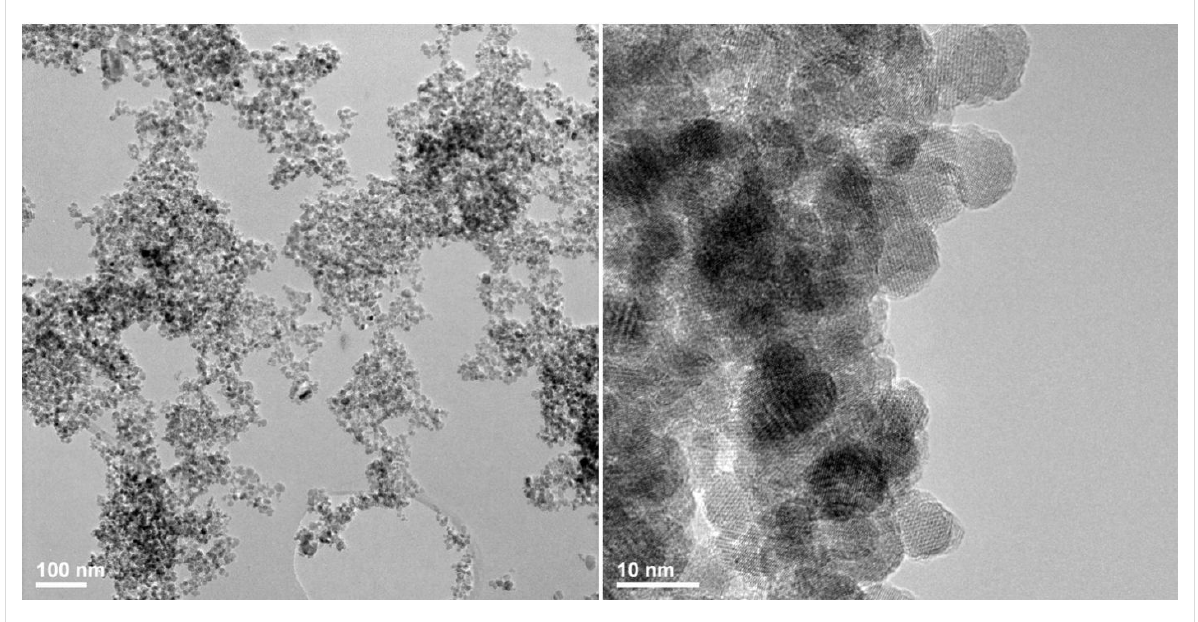
Figure 1: TEM images of prepared Fe 3 O 4 @EUG